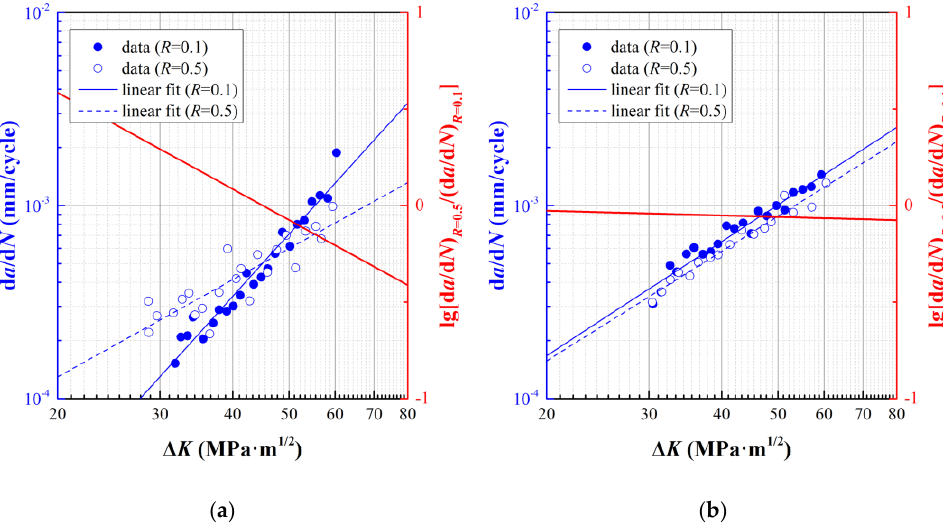
Table 4. Fitting parameters for the Paris model.